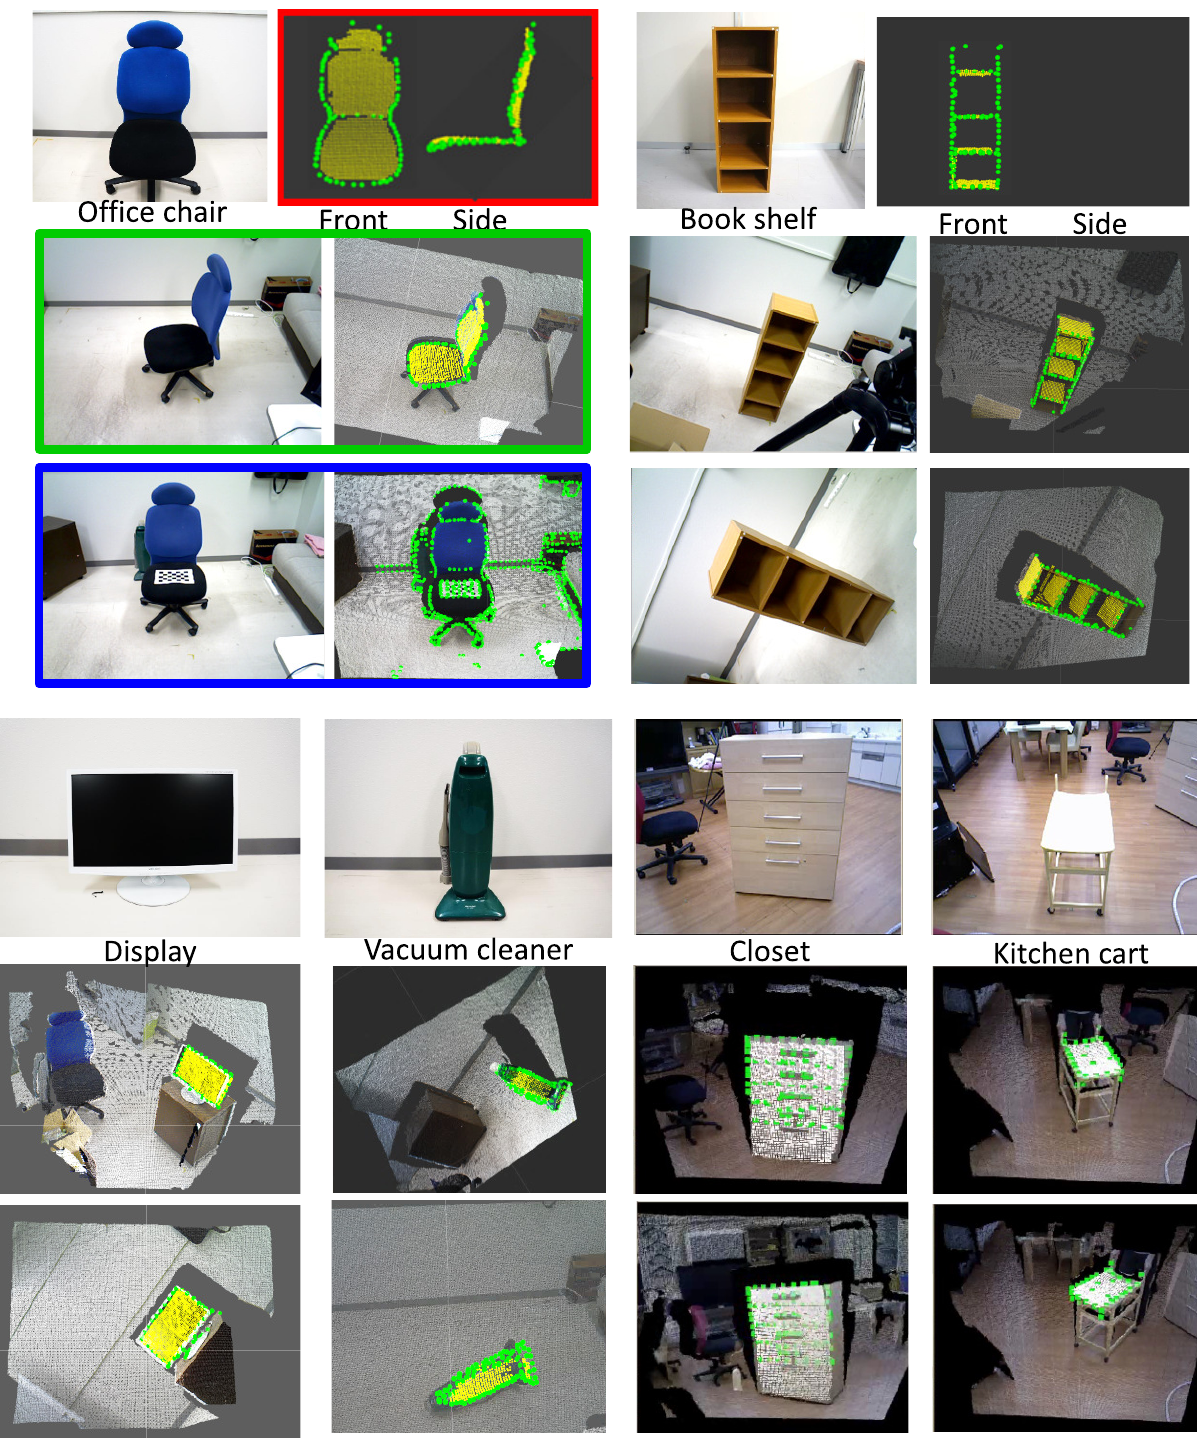
Figure 15: Some detection results. A small green sphere shows an edgel, and a yellow or white region shows a surface. A model repre- sented by these colored elements is superimposed onto an input point